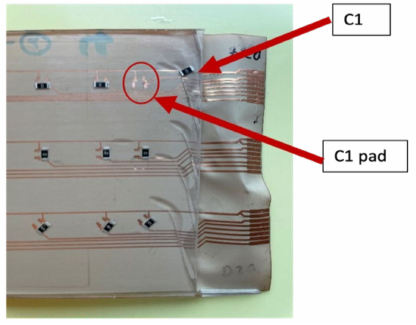
Figure 29. An out-of-place